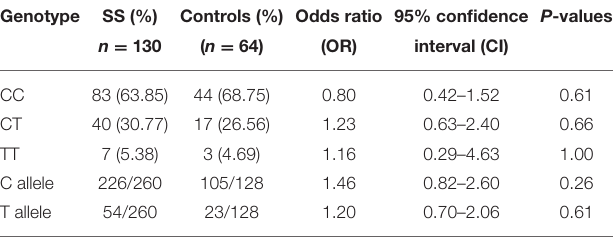
TABLE 6 | Comparison of IL-4 gene polymorphism genotype and allele frequencies between Steroid Sensitive (SS) patients and controls. Genotype SS (%) Controls (%) Odds ratio 95% confidence P -values